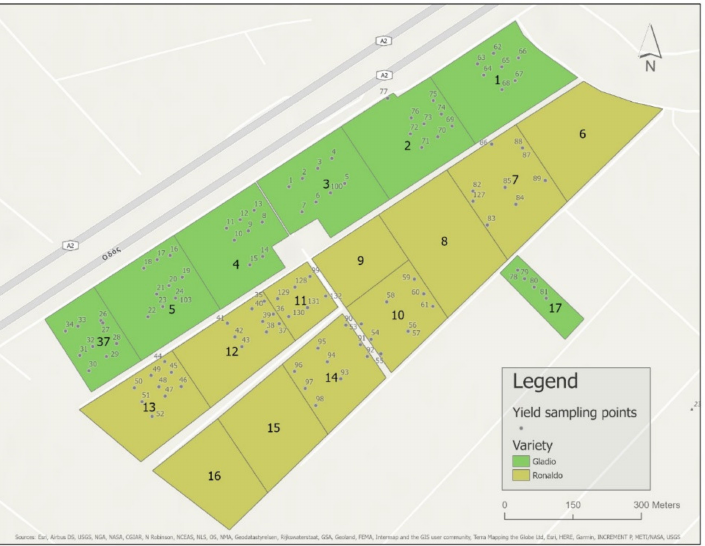
Figure 2. Study plots with the varieties investigated and yield sampling